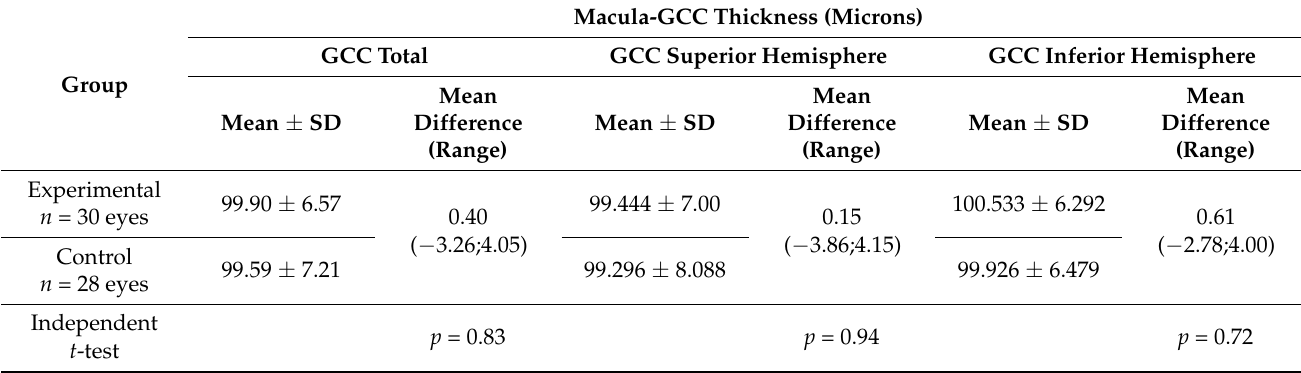
Table 3. A comparison of the ganglion cell complex (GCC) (microns) at the macula between the experimental (PSH) and control (normotensive) participants.